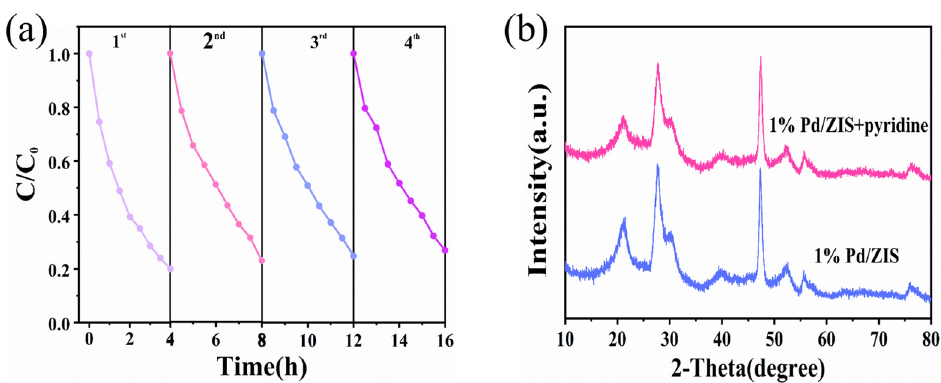
Figure 6. ( a ) Cycling experiments of photocatalytic denitrification of 1% Pd/ZIS; ( b ) XRD patterns of 1% Pd/ZIS after five cycles of